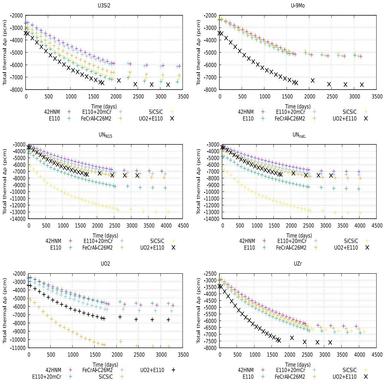
Total moderator and fuel temperature reactivity feedbacks (with respect to the melting points in.